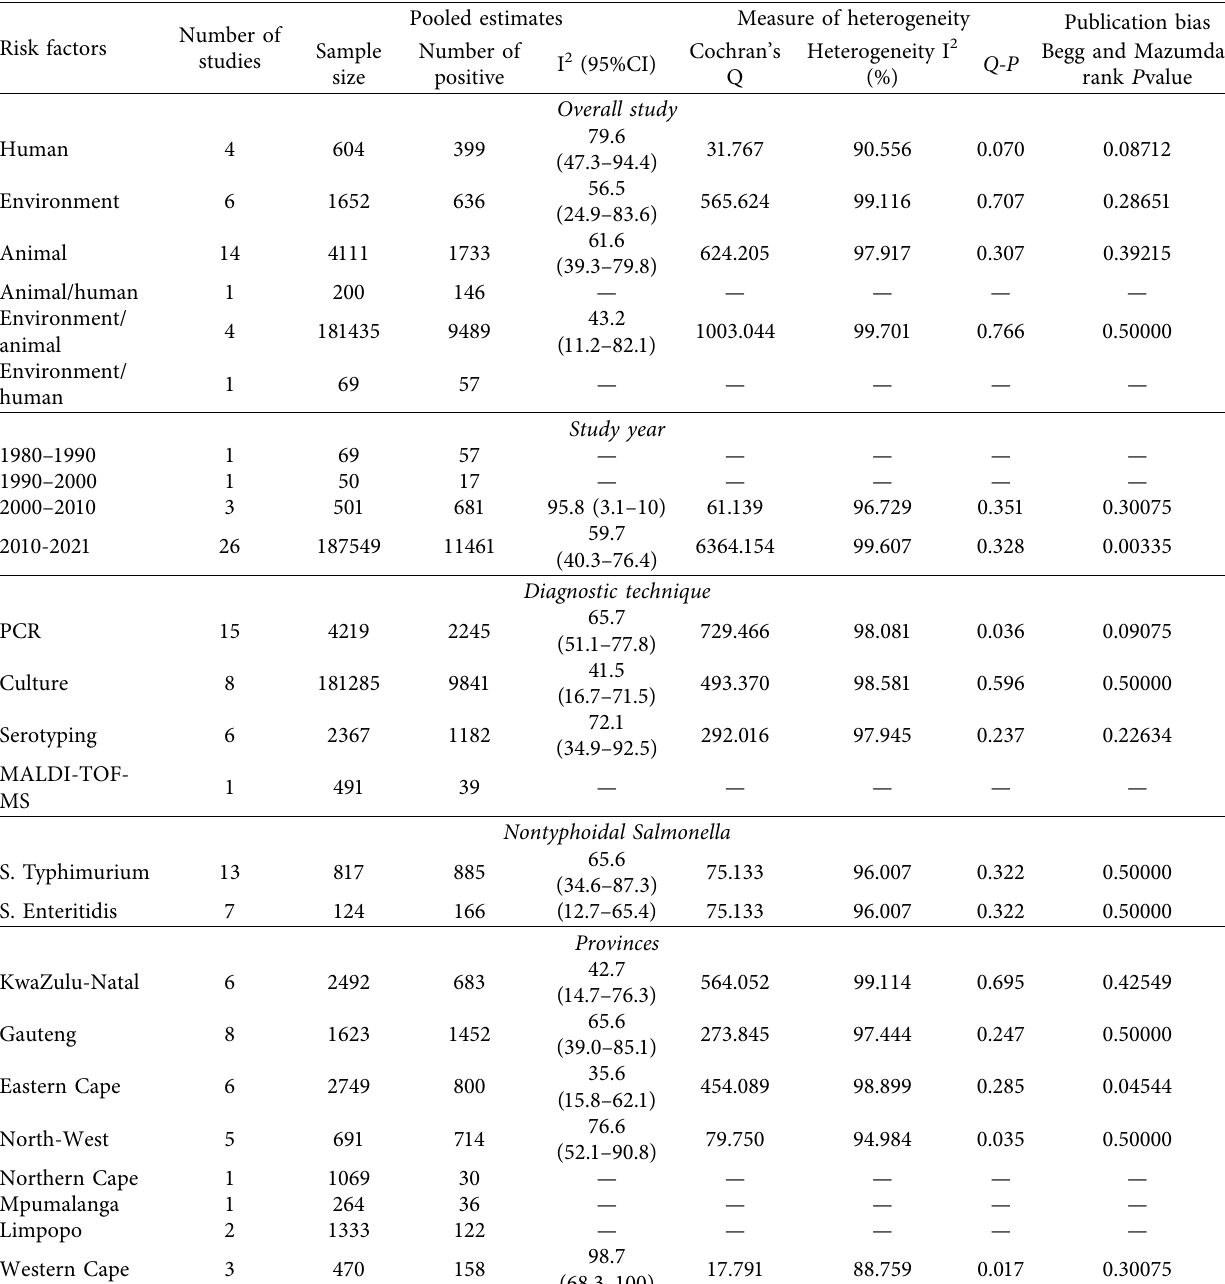
Table 3: Proportion of Salmonella serovars isolated from humans, the environment and animals, screening methods, study year, and sampling